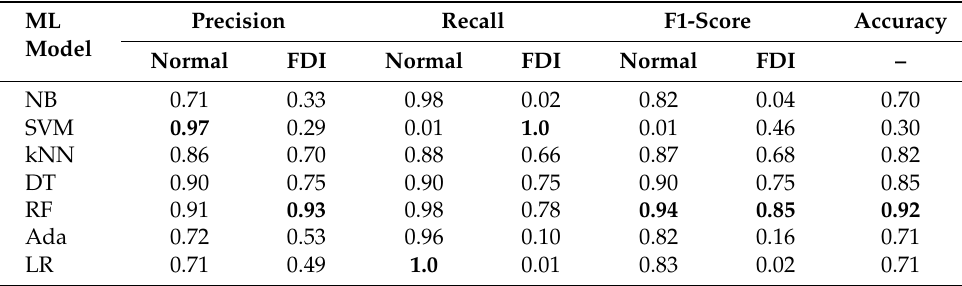
Table 5. Classifiers’ performance in the power dataset.